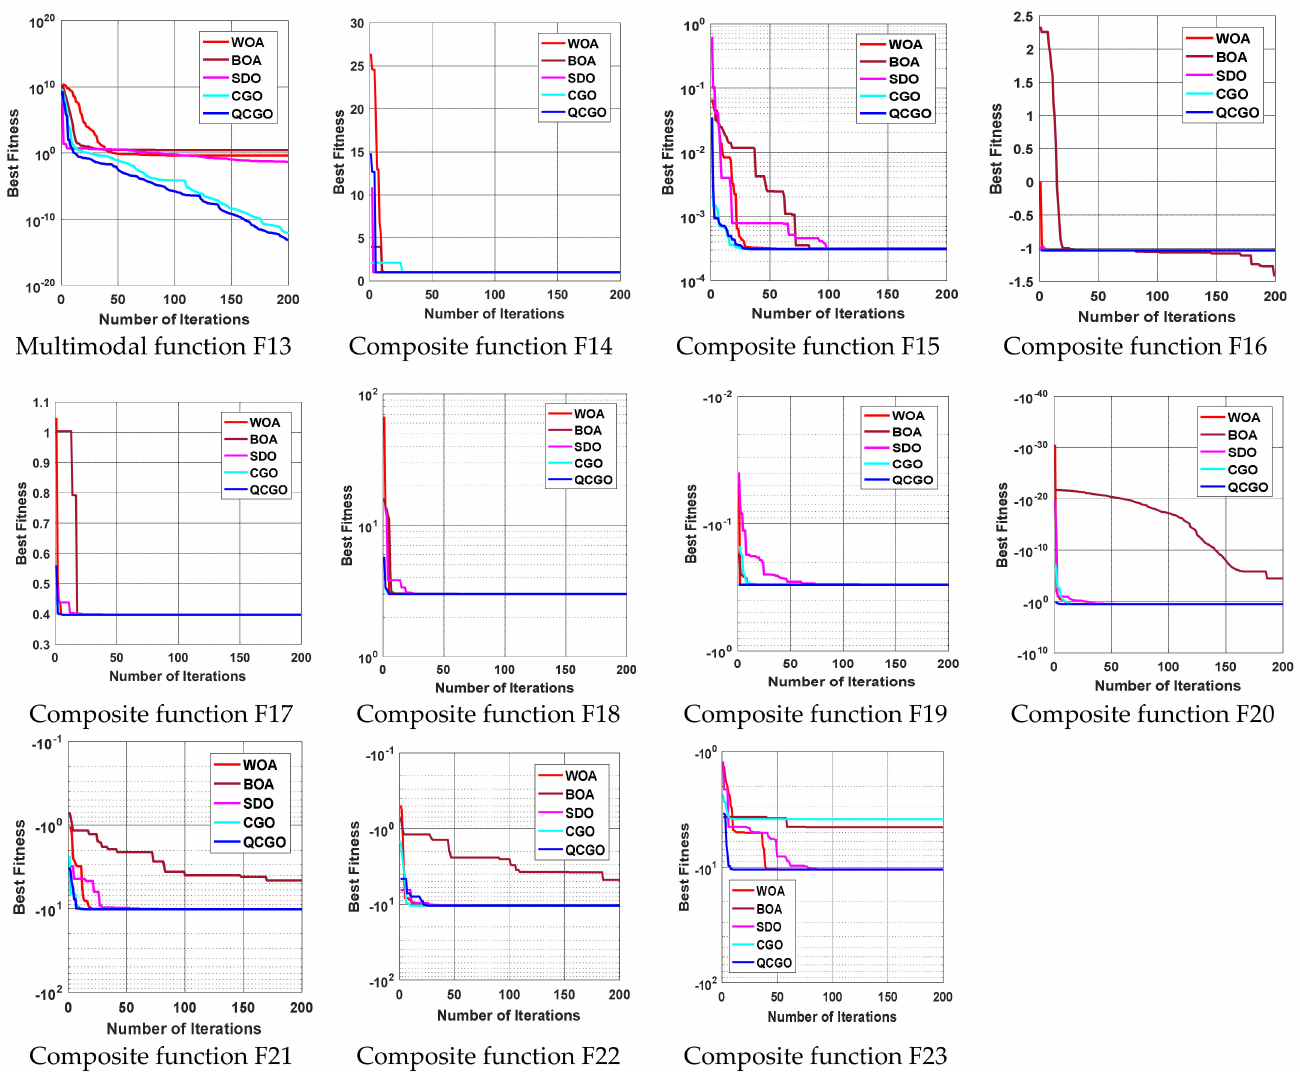
Figure 11. The convergence curves of the proposed QCGO algorithm and four other algorithms for 23 benchmark functions.